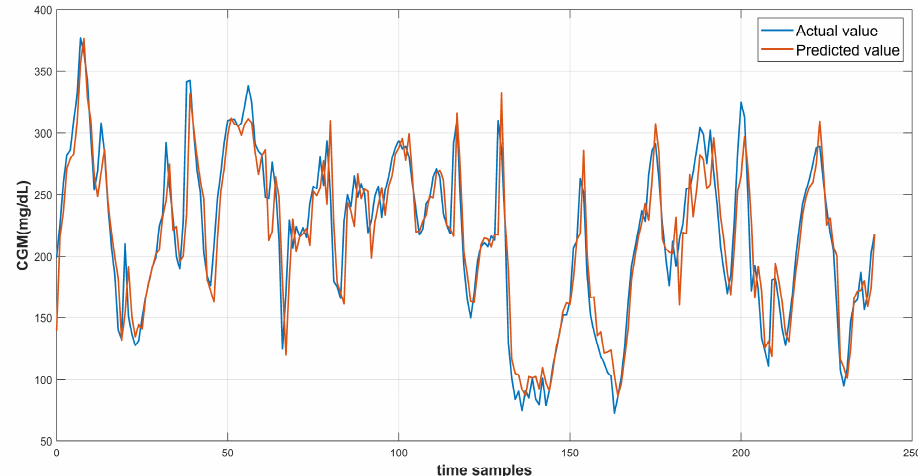
Figure 15. Prediction curve for patient ID 570 at PH of 60 min.